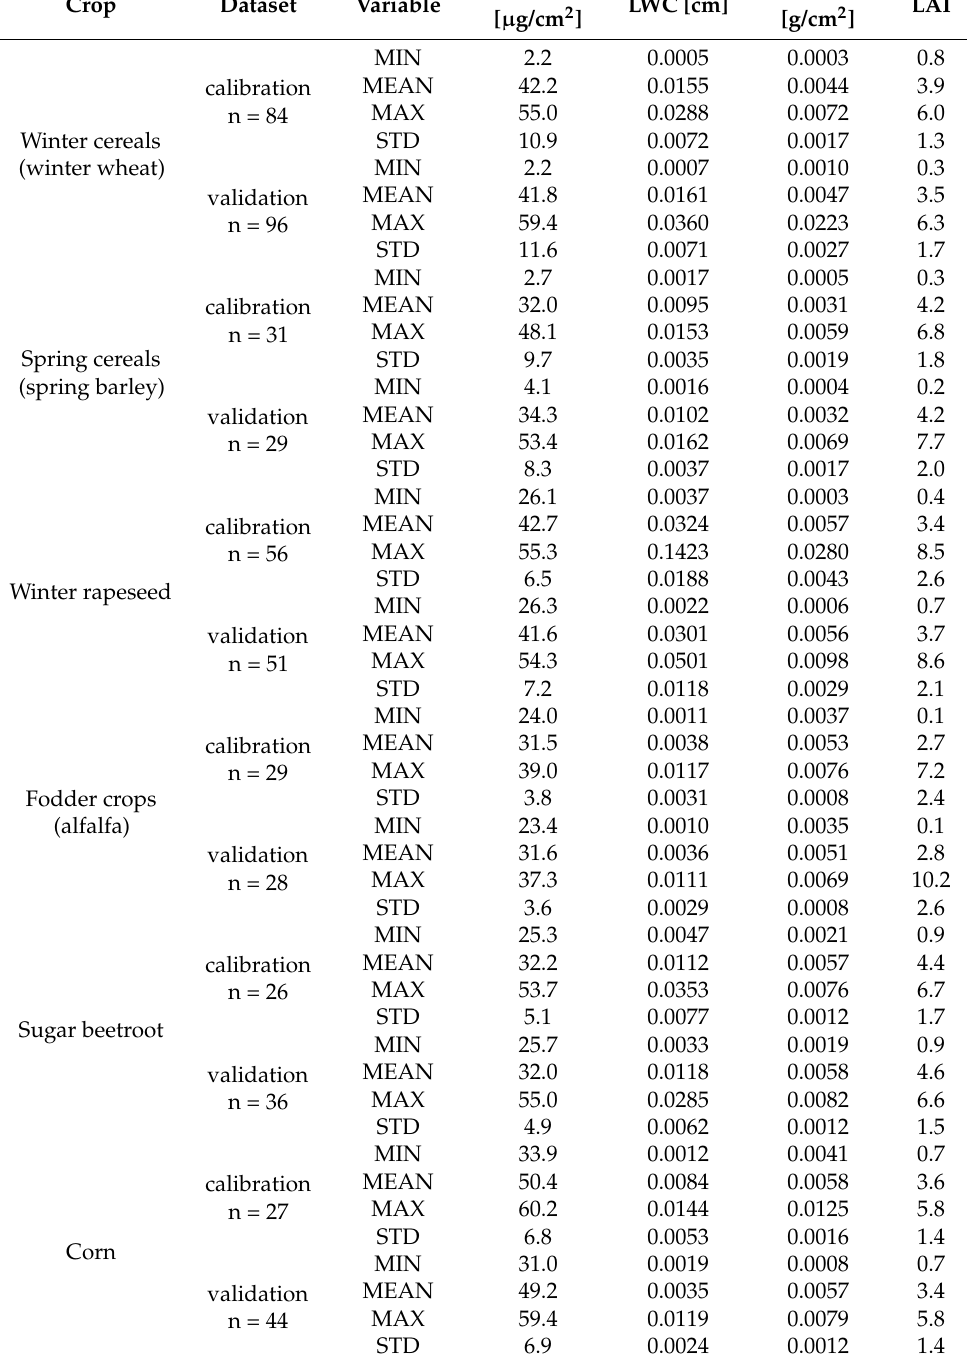
Table A1. Summary of the in-situ measured values of selected biophysical variables (LCC—leaf chlorophyll content, LWC—leaf water content, SLW—dry matter content (specific leaf weight) and LAI—leaf area